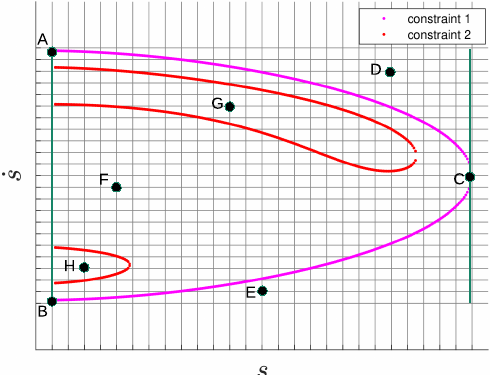
Figure 1. ( s , ˙ s ) constraints 1, 2 and a grid construction for satnum =